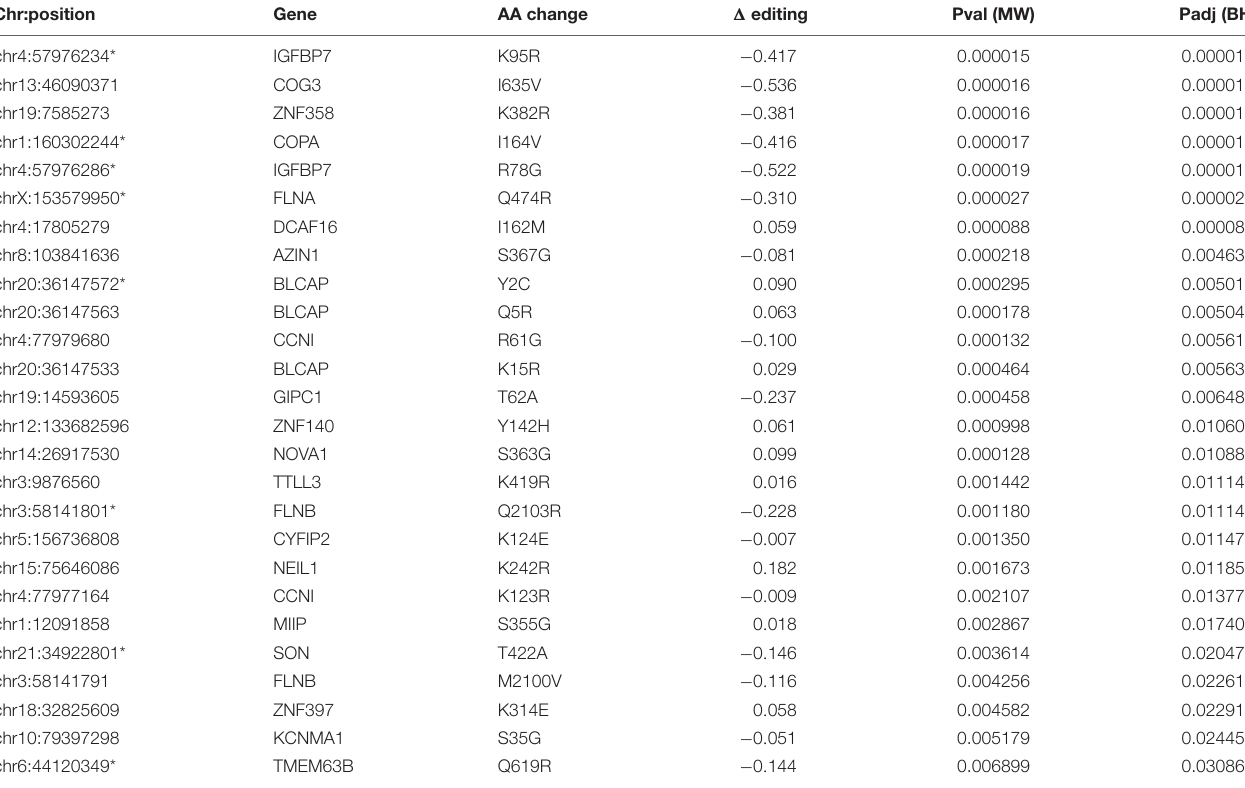
TABLE 2 | Statistically significant differential recoding